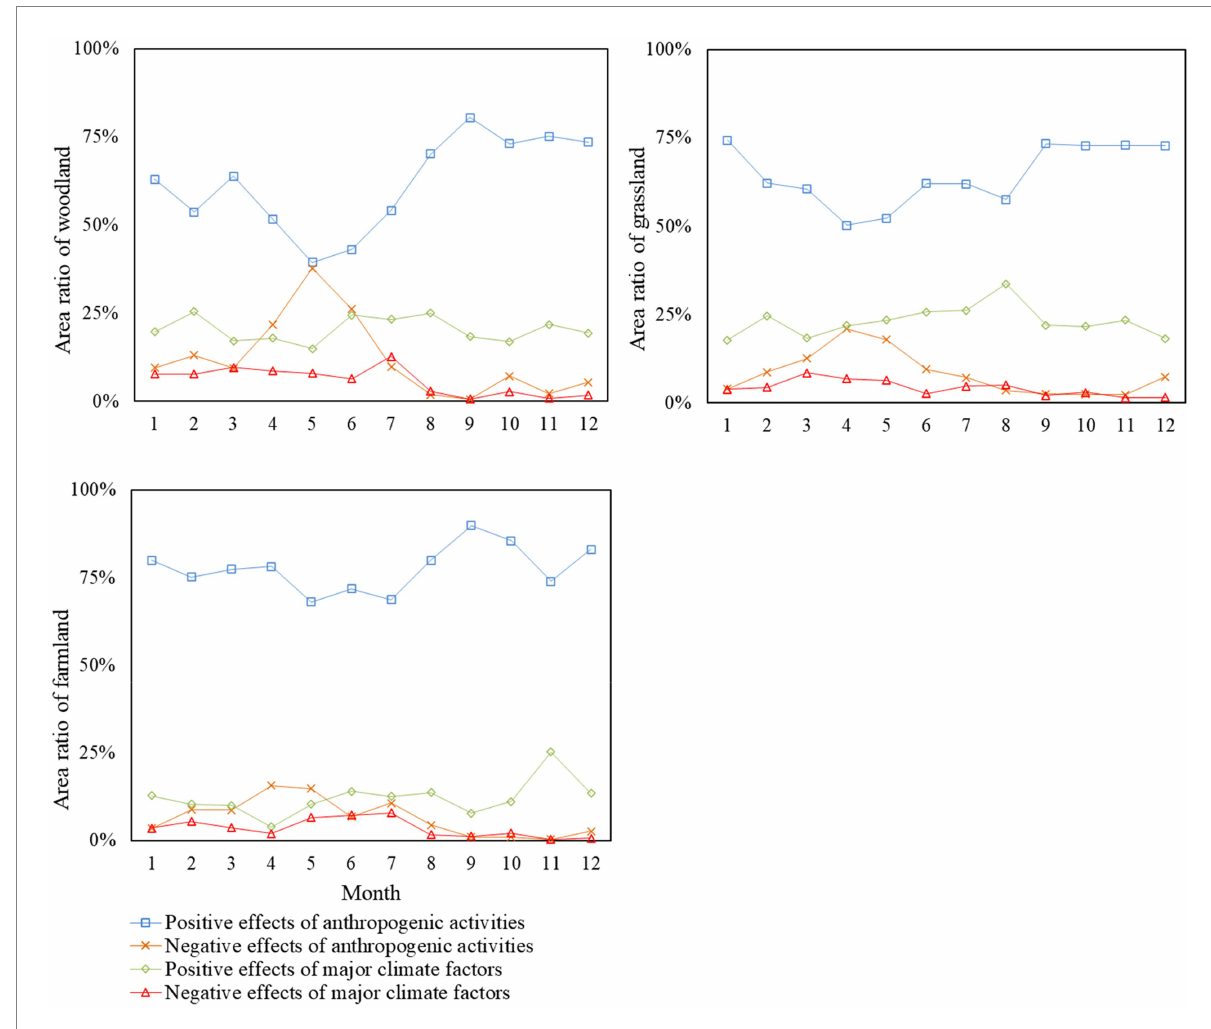
FIGURE 5 Area fraction with significant changes in ecosystems caused by anthropogenic activities and climate